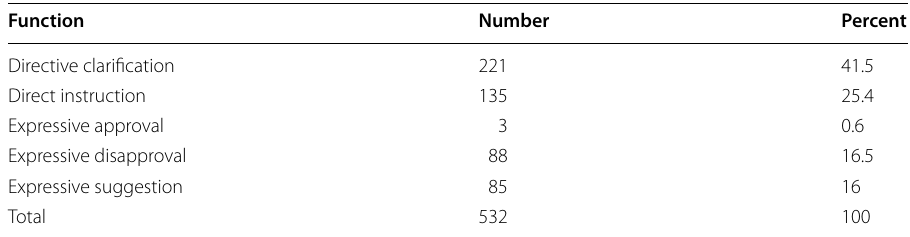
Table 2 Supervisors’ feedback language functions on students’ theses